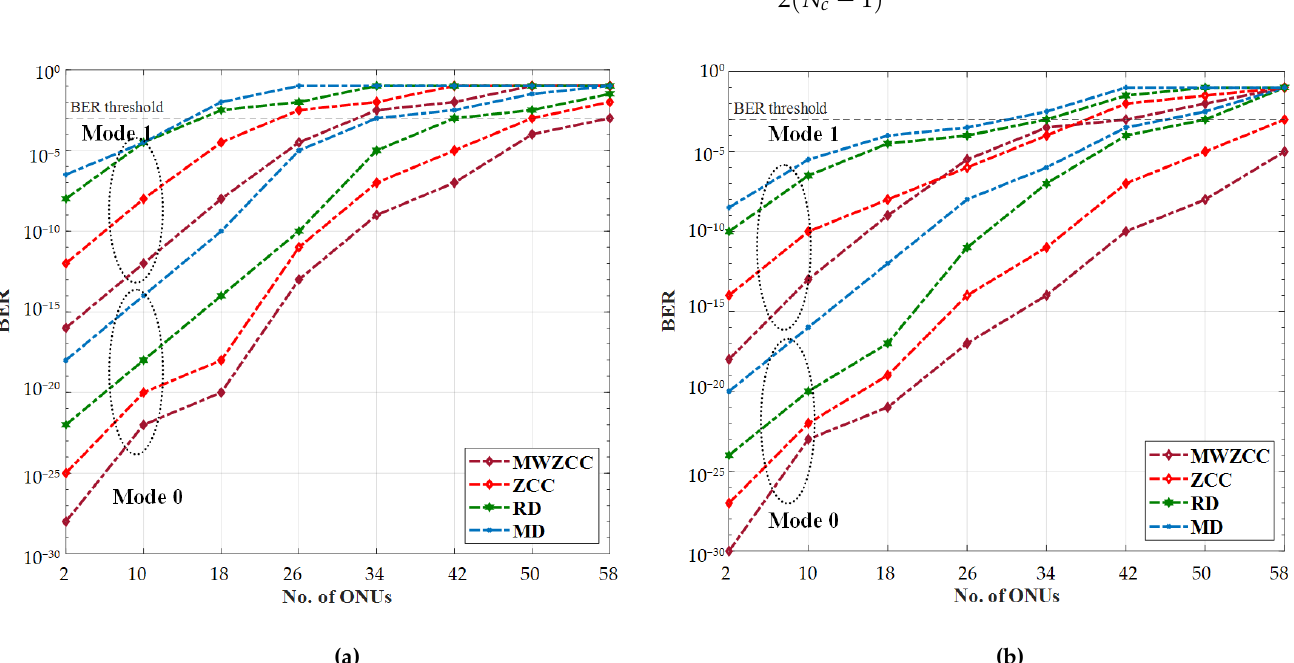
Figure 9. Measured BER vs. number of ONUs at 10/2.5 Gbit/s data rate over 1 km range for modes 0 and 1 for different codes in ( a ) downstream and ( b ) upstream transmission.